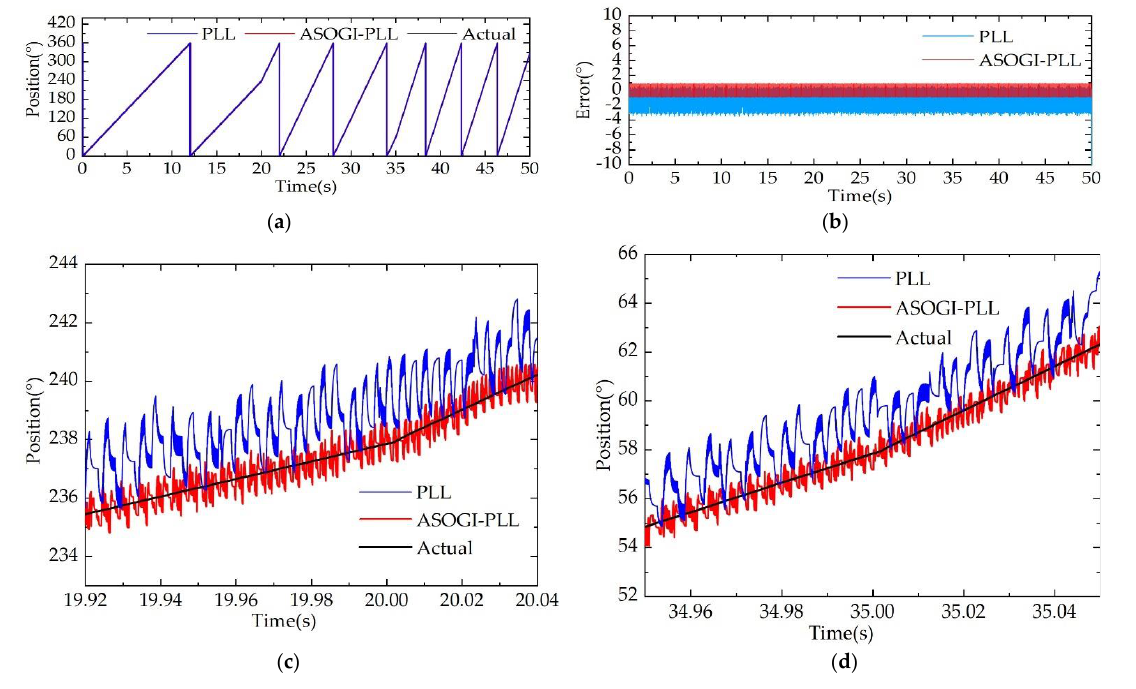
Figure 12. Speed up waveform: ( a ) Rotor position waveform; ( b ) Rotor position estimation error; ( c ) Rotor position local enlarged waveform at t = 20 s; ( d ) Rotor position local enlarged waveform at t = 35 s.